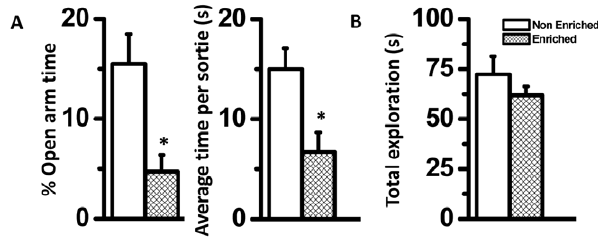
Figure 4. Enriched animals avoid threatening environment. Enriched animals exhibit specific avoidance of threatening open arms of an elevated plus maze, n=7 (A). Enriched animals explore novel objects similarly as control animals (B), n=6, *, p , 0.05; exact Mann-Whitney